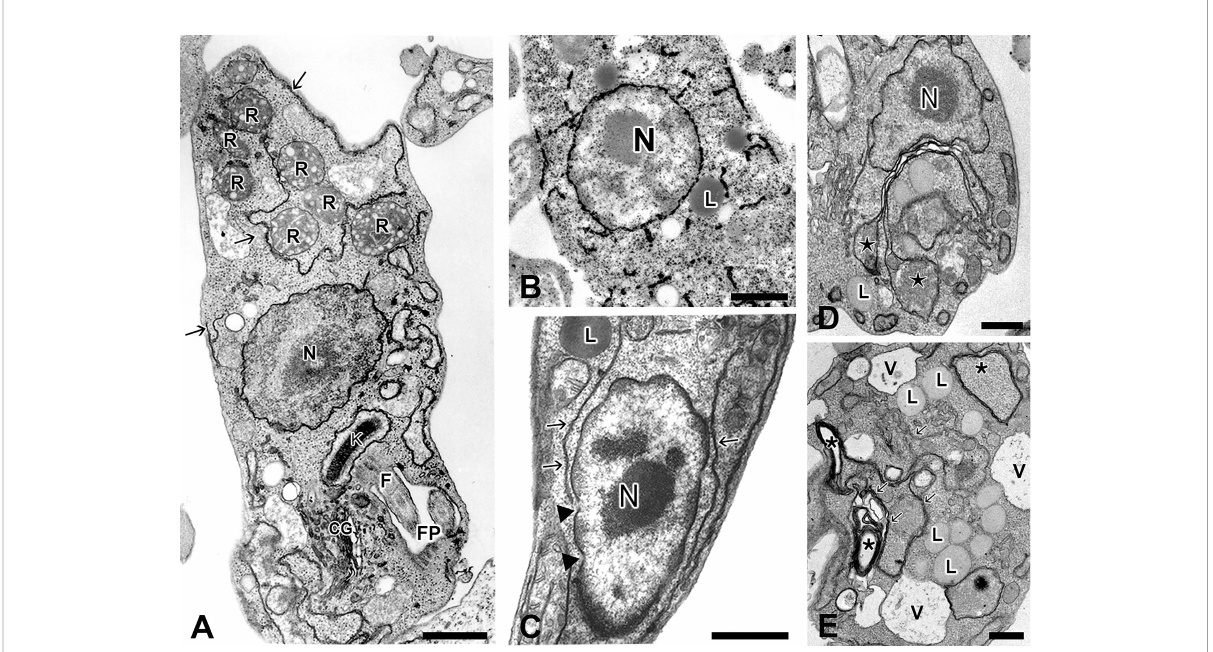
FIGURE 2 Different morphological views of ER from Trypanosoma cruzi and Leishmania spp as observed by TEM. (A) Epimastigotes of T. cruzi processed as routine for TEM, showing scarce pro fi les of ER (arrows) in close association with plasma membrane and reservosomes (R); (B) Detail of an epimastigote submitted to post- fi xation with osmium tetroxide/potassium iodide and then processed for TEM, showing electron dense deposits on the nuclear envelope and endoplasmic reticulum (from Figueiredo and Soares, 1995); (C) High magni fi cation of a promastigote form of Leishmania showing ER pro fi les (arrows) in the vicinity of nucleus and plasma membrane. Note the presence of well-de fi ned nuclear pores (arrowhead) on the nuclear envelope; (D – E) Epimastigotes of T. cruzi treated with low (D) and high (E) concentrations of Tunicamycin (TM), a potent inductor of ER stress, for 72 hours. At low concentration of TM, it is possible to observe an evident increase of ER pro fi les (from